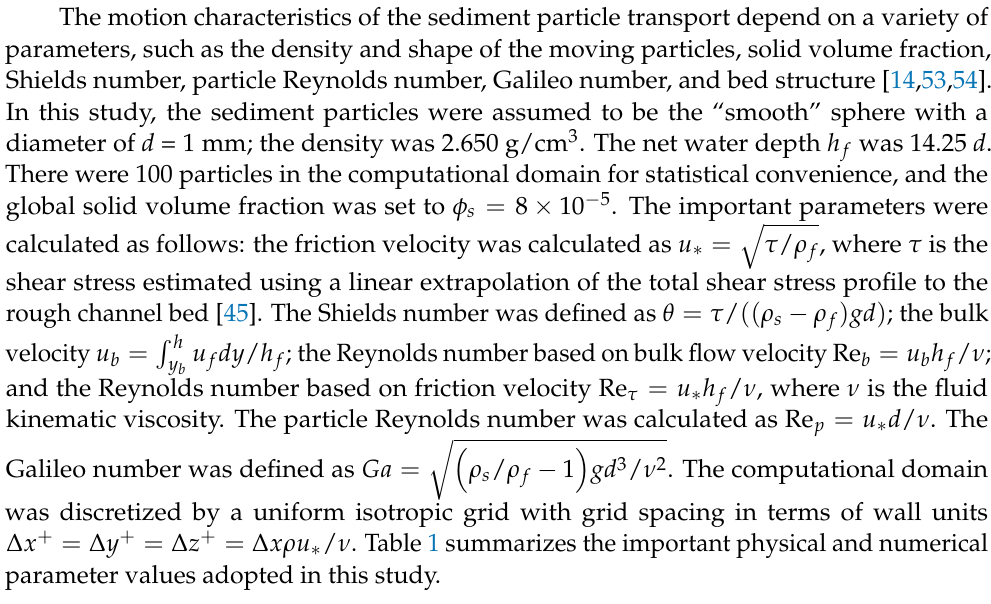
Table 1. Physical and numerical parameters of numerical